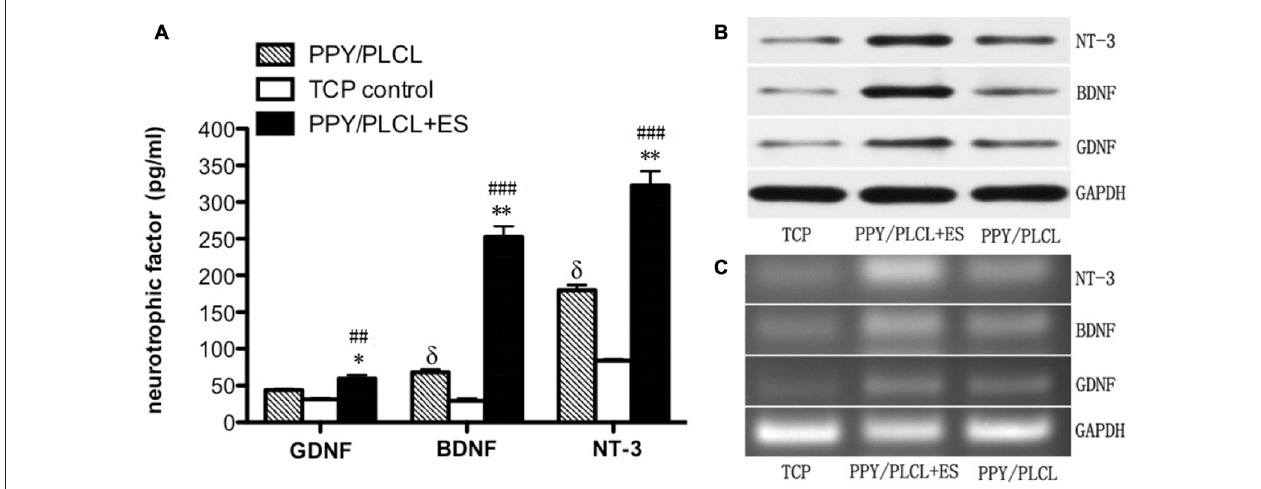
FIGURE 4 | Glial cell derived neurotrophic factor (GDNF), brain-derived neurotrophic factor (BDNF) and neurotrophin-3 (NT-3) expression in dorsal root ganglia (DRG) cells 24 h after ES. (A) ELISA measurement. (B) Protein levels by Western blot assay. (C) Relative mRNA expression by RT-PCR ( n = 6, ## p < 0.01, ### p < 0.001 the PPY/PLCL + ES group vs. TCP control group; ∗ p < 0.05, ∗∗ p < 0.01 the PPY/PLCL + ES group vs. PPY/PLCL group; δ p < 0.05, the PPY/PLCL group vs. TCP control group).